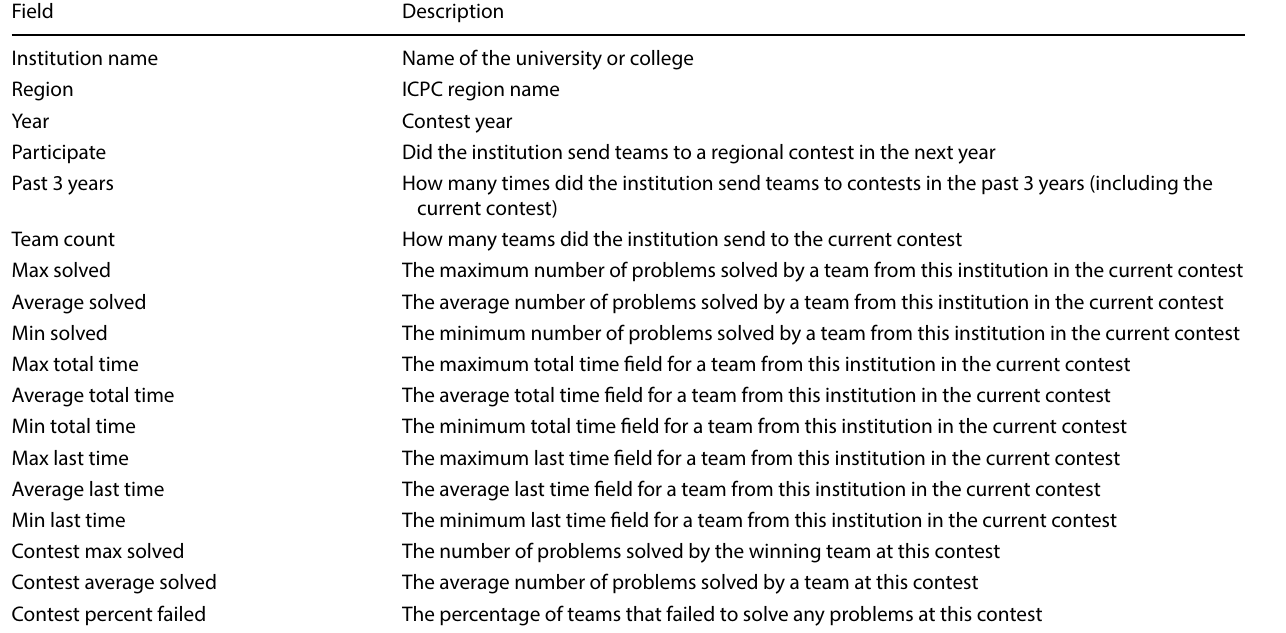
Table 2 Attributes after aggregation by institution, region, and year Field